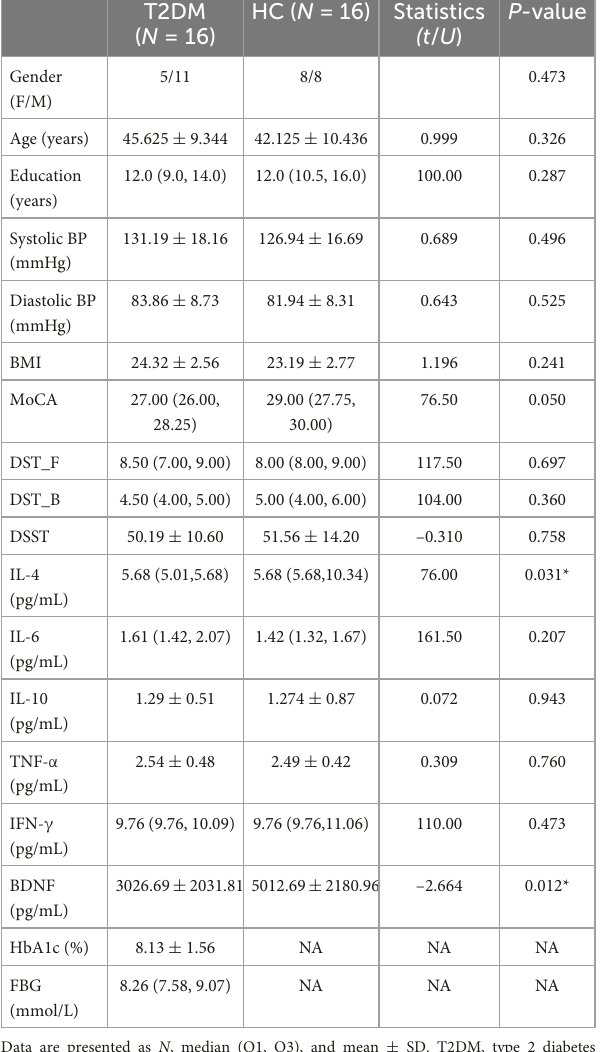
TABLE 1 Demographics and clinical characteristics of the